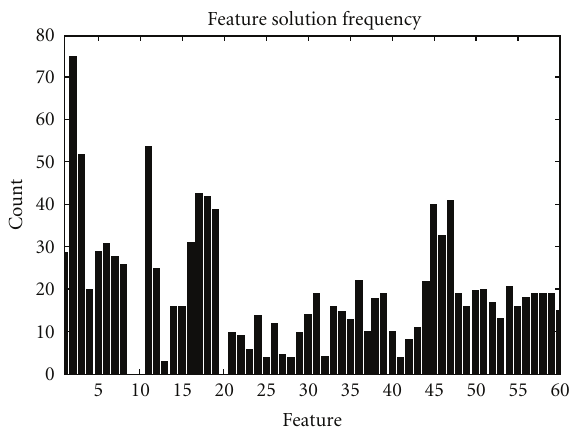
Figure 10: The frequency of each feature in the 150 SA solutions evaluated on the Bos Wars Test Set. Table 6: Results for the solutions found with the best parameters by the deterministic and stochastic algorithms.